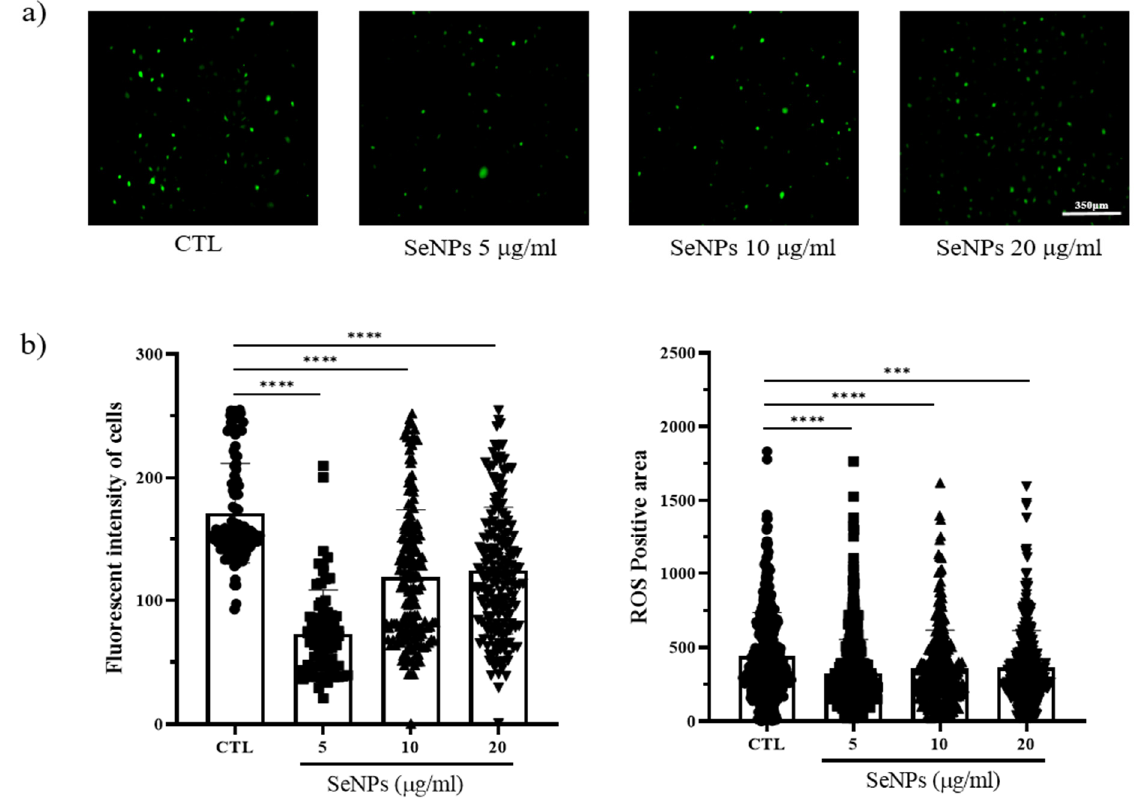
Figure 4. MC3T3-E1 cells were exposed to 400 µ M H 2 O 2 for oxidative stress and then recovered by culturing in medium with or without SeNPs. High oxidative stress conditions were enabled by pretreatment with H 2 O 2 for 4 h. ( a ) SeNP treatment resulted in reduced levels of reactive oxygen species (ROS). ( b ) The fluorescence intensity of cells and ROS-positive areas was measured using ImageJ. Statistical significance was calculated using one-way ANOVA followed by a two-sided Dunnett post hoc test compared to CTL (scale bar = 350 µ m). **** Represents p < 0.0001; n = 5.